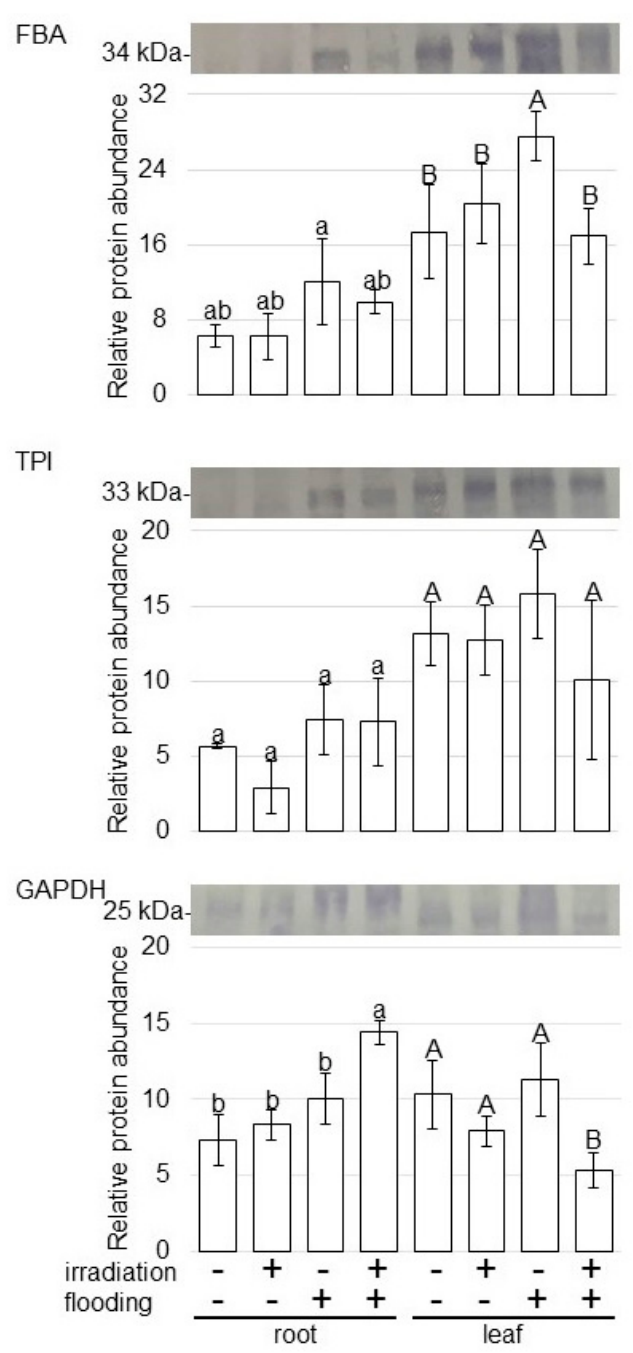
Figure 5. Immunoblot analysis of proteins involved in glycolysis in wheat irradiated with millimeter waves under flooding stress. Proteins extracted from the roots and leaves of wheat seedlings were separated on SDS-polyacrylamide gel by electrophoresis and transferred onto membranes. The membranes were cross-reacted with anti-FBA, TPI, and GAPDH antibodies. Staining pattern with Coomassie-brilliant blue was used as a loading control (Figure S4). The integrated densities of bands were calculated using ImageJ software. The data are given as the mean ± SD from three independent biological replicates (Figures S5–S7). The statistical analysis is same as Figure